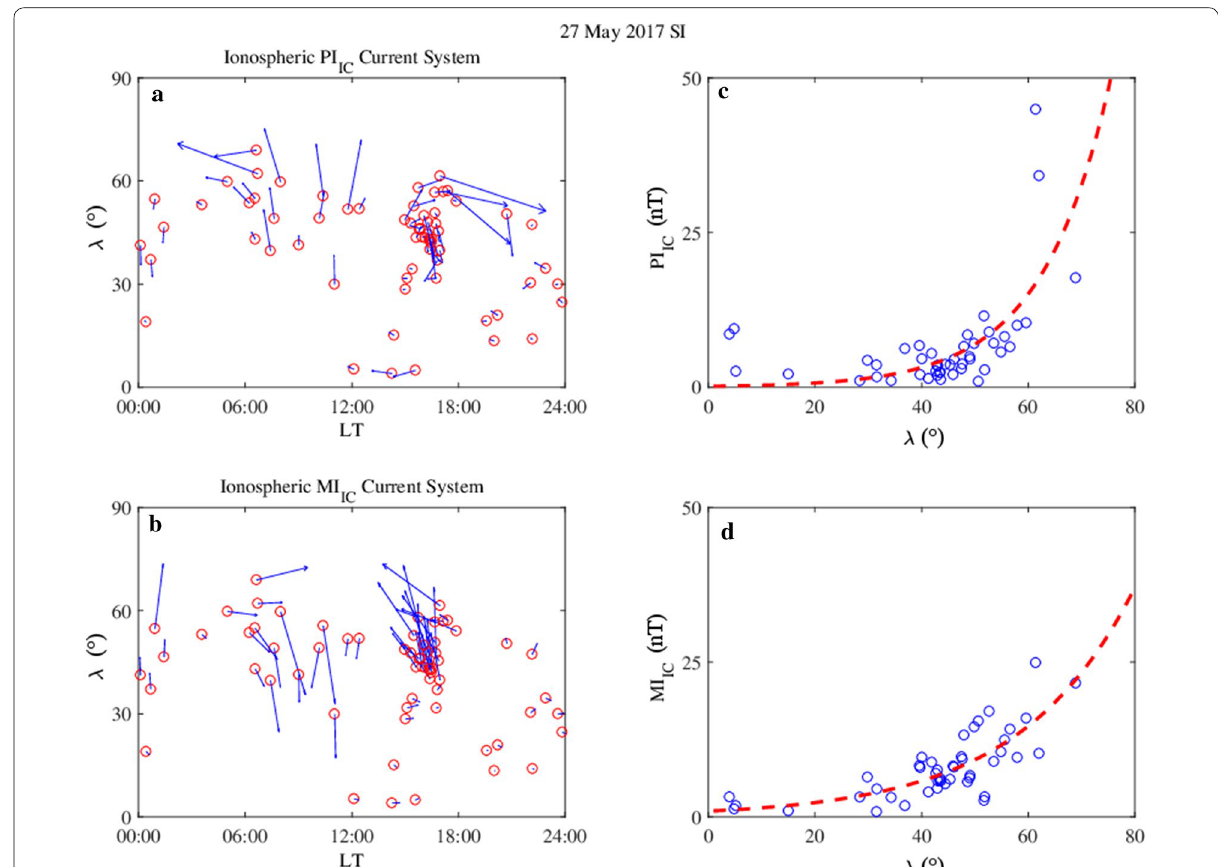
Fig. 10 a , b The ionospheric current directions (blue arrows) as obtained on 27 May 2017 for PI IC at 15:33 UT and for MI IC at 15:42 UT, versus geomagnetic latitude ( λ ) and LT, after a 90° rotation of the DP fields. Red circles correspond to the geomagnetic location of the INTERMAGNET stations. Corresponding amplitudes (blue circles) in the dayside sector (06 < LT < 18) are shown in c , d versus λ , with corresponding exponential fits as red dashed curves. The local enhancement observed around the magnetic equator, which is particularly evident in the PI IC amplitude, is